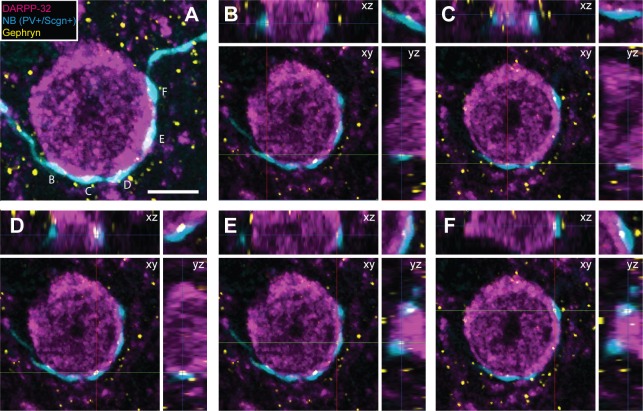
Appositions formed by the axons of PV+ interneurons with the somata of SPNs are associated with the post-synaptic marker gephyrin.(A) Confocal micrograph stack of an SPN cell body, labeled with DARPP-32 (purple), that is apposed by the boutons of a neurobiotin (NB)-labeled axon of a PV+/Scgn+ interneuron (blue). The section has also been labeled with an antibody against the post-synaptic structural protein gephyrin (yellow). Scale bar = 5 µm. (B–F), Single-plane confocal micrographs showing the xy axis and the corresponding orthogonal views; xz (top) and yz (right) of the 5 appositions labeled in A. Axes crossing points are marked by colored lines. The top right corner panel shows a magnification of the apposition in the xy axis. Note that, for each apposition, there is a punctate gephyrin signal located between the axonal bouton and the soma, indicating the presence of a putative GABAergic synapse.